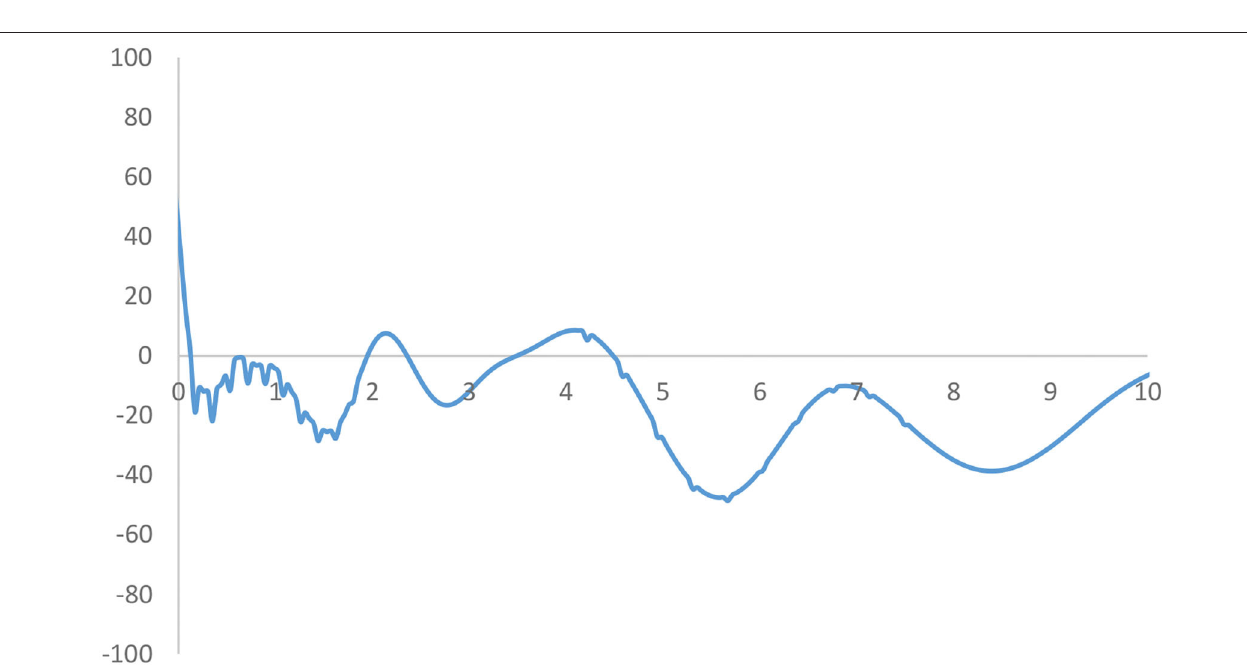
with the RIVAPC values around 0.7) until it intersects the horizontal axis again at the RIVAPC value of 1.95. Thus, among countries which had below-average industrial development,